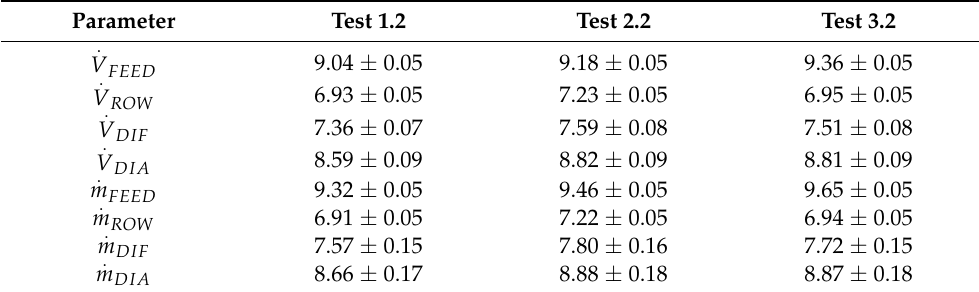
Table 5. Inlet and outlet stream flows (volumetric flows in L · h − 1 and mass flows in kg · h − 1 ) . V FEED ( ROW / DIF / DIA ) — volumetric flow rate of feed for Tests 1.2, 2.2 and 3.2. Symbols: . m FEED ( ROW / DIF / DIA ) —mass flow rate of feed (RO perme- (RO permeate/diffusate/dialysate), ate/diffusate/dialysate).